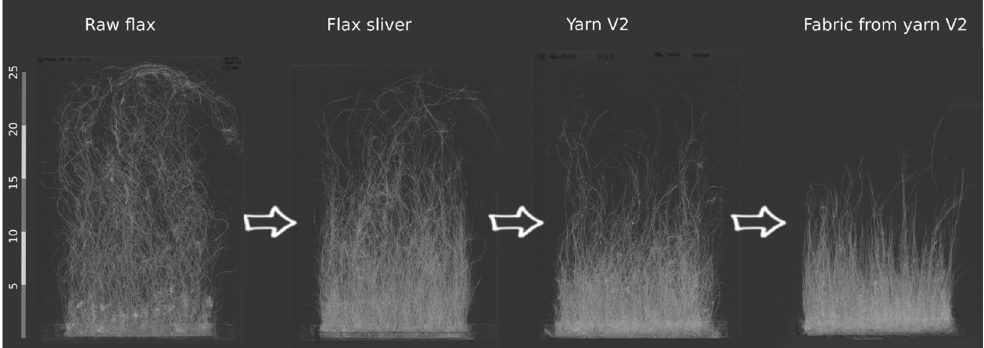
Figure 4. Length distribution depending on the subsequent processing—from raw flax to fabric.